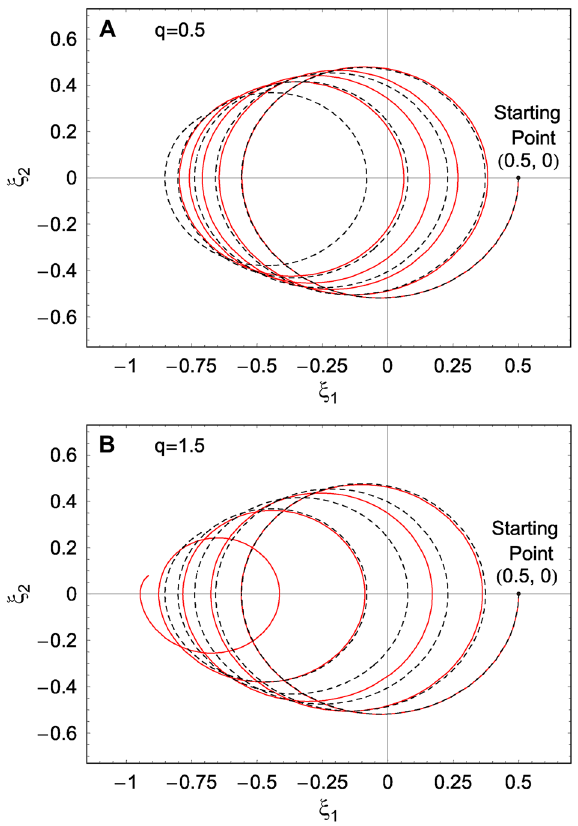
Figure 4. Parametric plot of ξ( t ) (i.e., ξ 1 ( t ) and ξ 2 ( t ) ) which are developed using DCOSHO. This is plotted using the real and imaginary parts of Eq. (61) in “Methods” section, under a low-damping limit within the time interval ( t i , t f ) (0, 15). If the magnitude of the damping factor is sufficiently high, the parametric behavior of = ξ( t ) is quite different from this (see Fig. 2 in Ref. 36). The initial condition we have taken is ξ 1 ( 0 ) 0 . The value of q for the solid red curve is 0.50 for A and 1.50 for B . An extra curve (dashed black curve) ξ 2 ( 0 ) = is added as a reference one which corresponds to the case of q